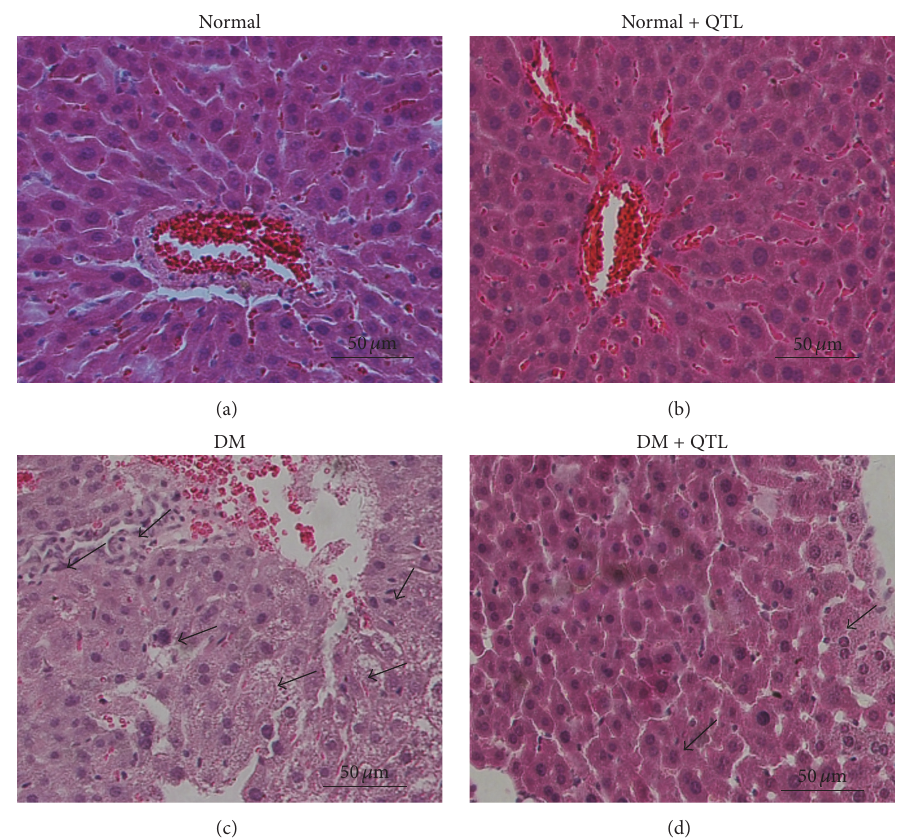
Figure 3: Effect of QTL on hepatic morphological changes (H&E staining). (a) Normal; (b) normal + QTL; (c) diabetic; (d) diabetic + QTL; ( 𝑛 = 3 ; 20x; scale bar 100 𝜇